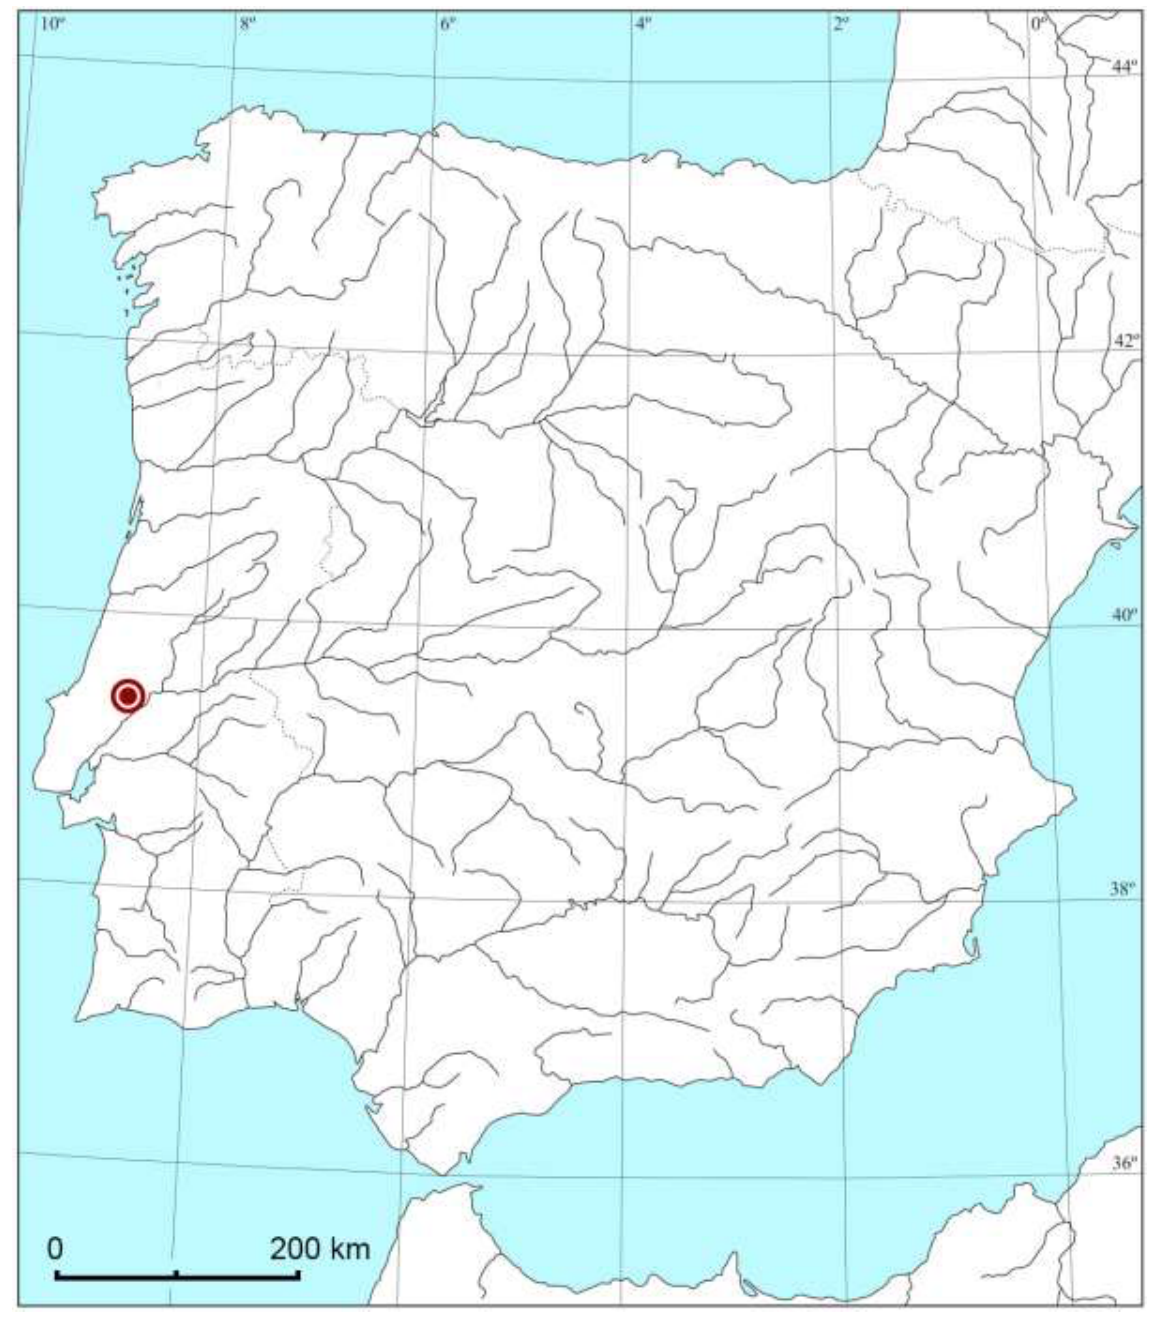
Figure 1. Location of the cave in the scope of the Iberian